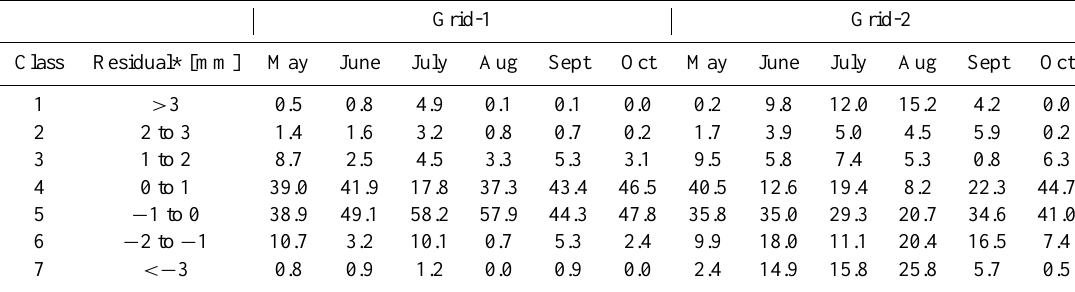
Table 4. Percent area distribution of pixel residual for rainy months